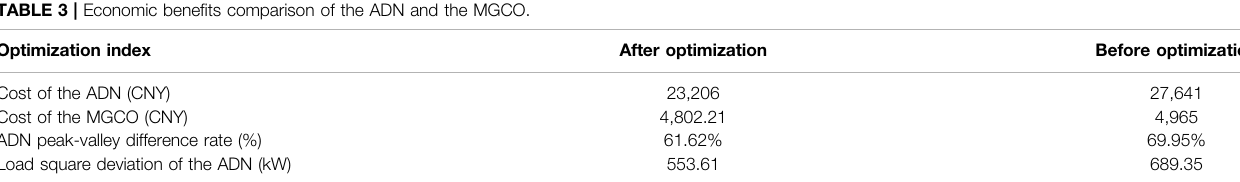
TABLE 3 | Economic bene fi ts comparison of the ADN and the MGCO. Optimization